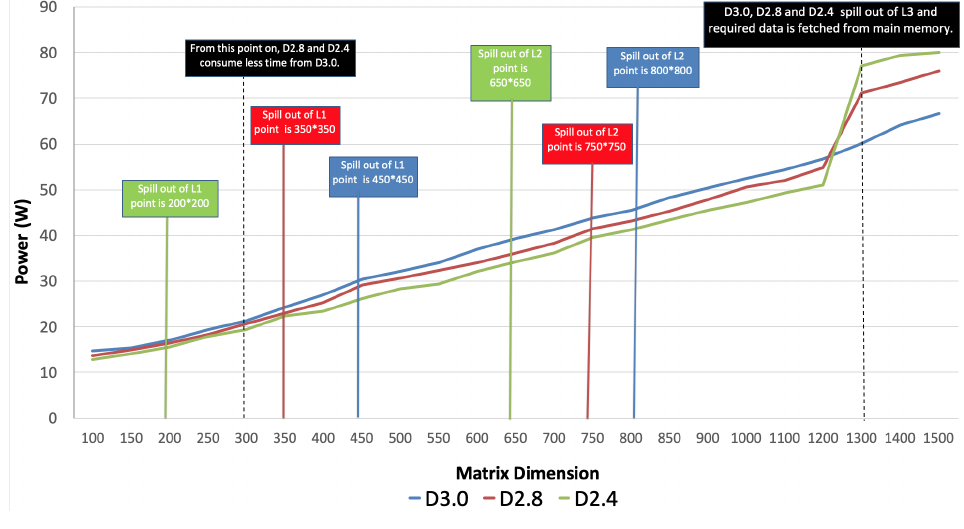
Figure 2. Power consumption in watts (W): estimated boundaries for L1, L2, and L3 caches marked for each case. Note the recursive divide-and-conquer methods spilled earlier due to increased stack storage